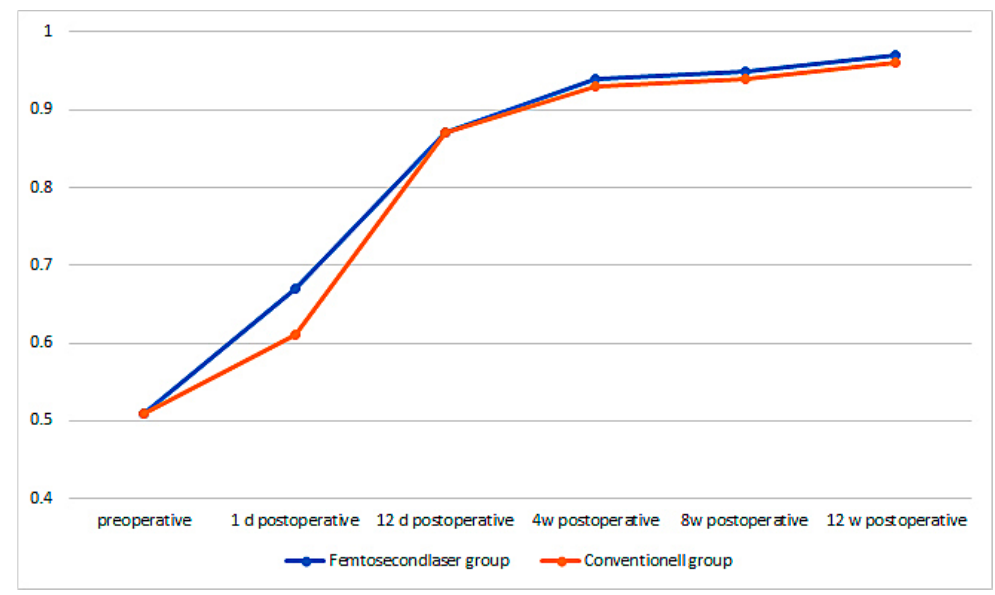
Figure 6. Best corrected visual acuity (BCVA) over time for both groups . The mean absolute error (MAE) is defined as the difference between the predicted and achieved postoperative spherical equivalence refraction. In the femtosecond laser group, the MAE was − 0.20 ± 0.49 D (range − 1.46–1.11) and in the conventional group it